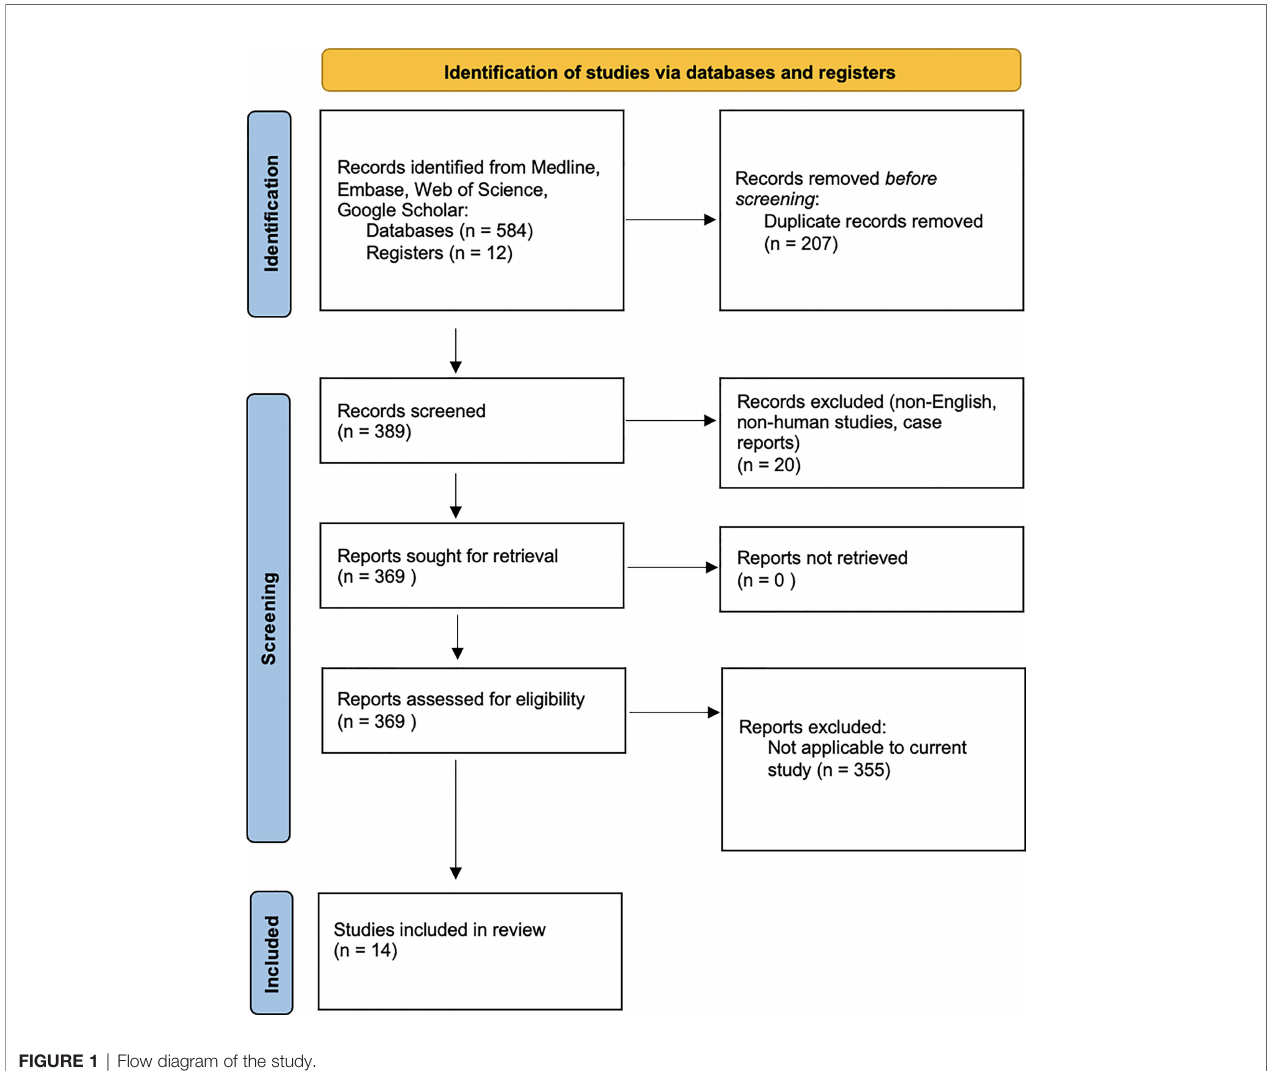
FIGURE 1 | Flow diagram of the study. TABLE 1 | Descriptive studies of acute microbiology in adult patients with